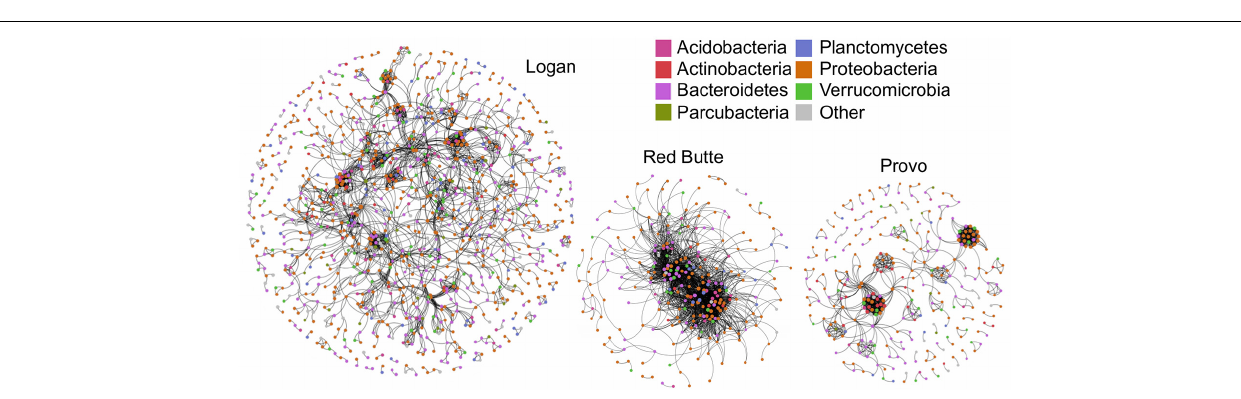
FIGURE 7 | Network co-occurrence models for bacterial communities collected along elevation and urbanization gradients in three Utah watersheds (Red Butte Creek, Provo River, and Logan River) across three seasons (Fall, Winter, and Spring). Nodes indicate taxa (OTUs, taxa with 97% similar sequences) and edges connect where significant co-occurrence was detected in 75% of samples. Topologic statistics of the network are shown in Table 6